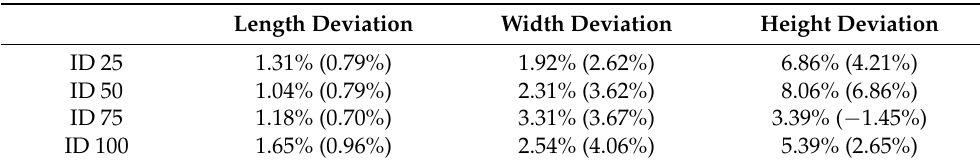
Table 3. Mean values for the deviations between the final part and CAD model. Length and width represent the printing plane and height of the stacking direction. The deviations adjusted for the scaling factor bias are given in